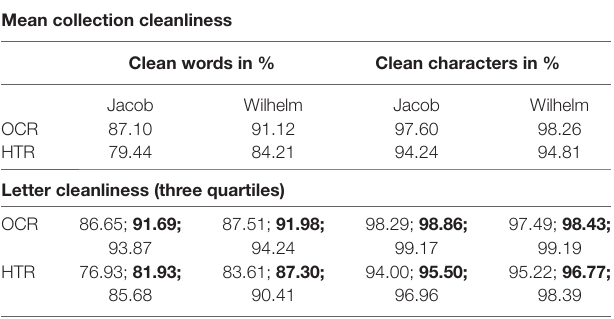
Table 6 | Cleanliness of the collection of 72 letters by author.